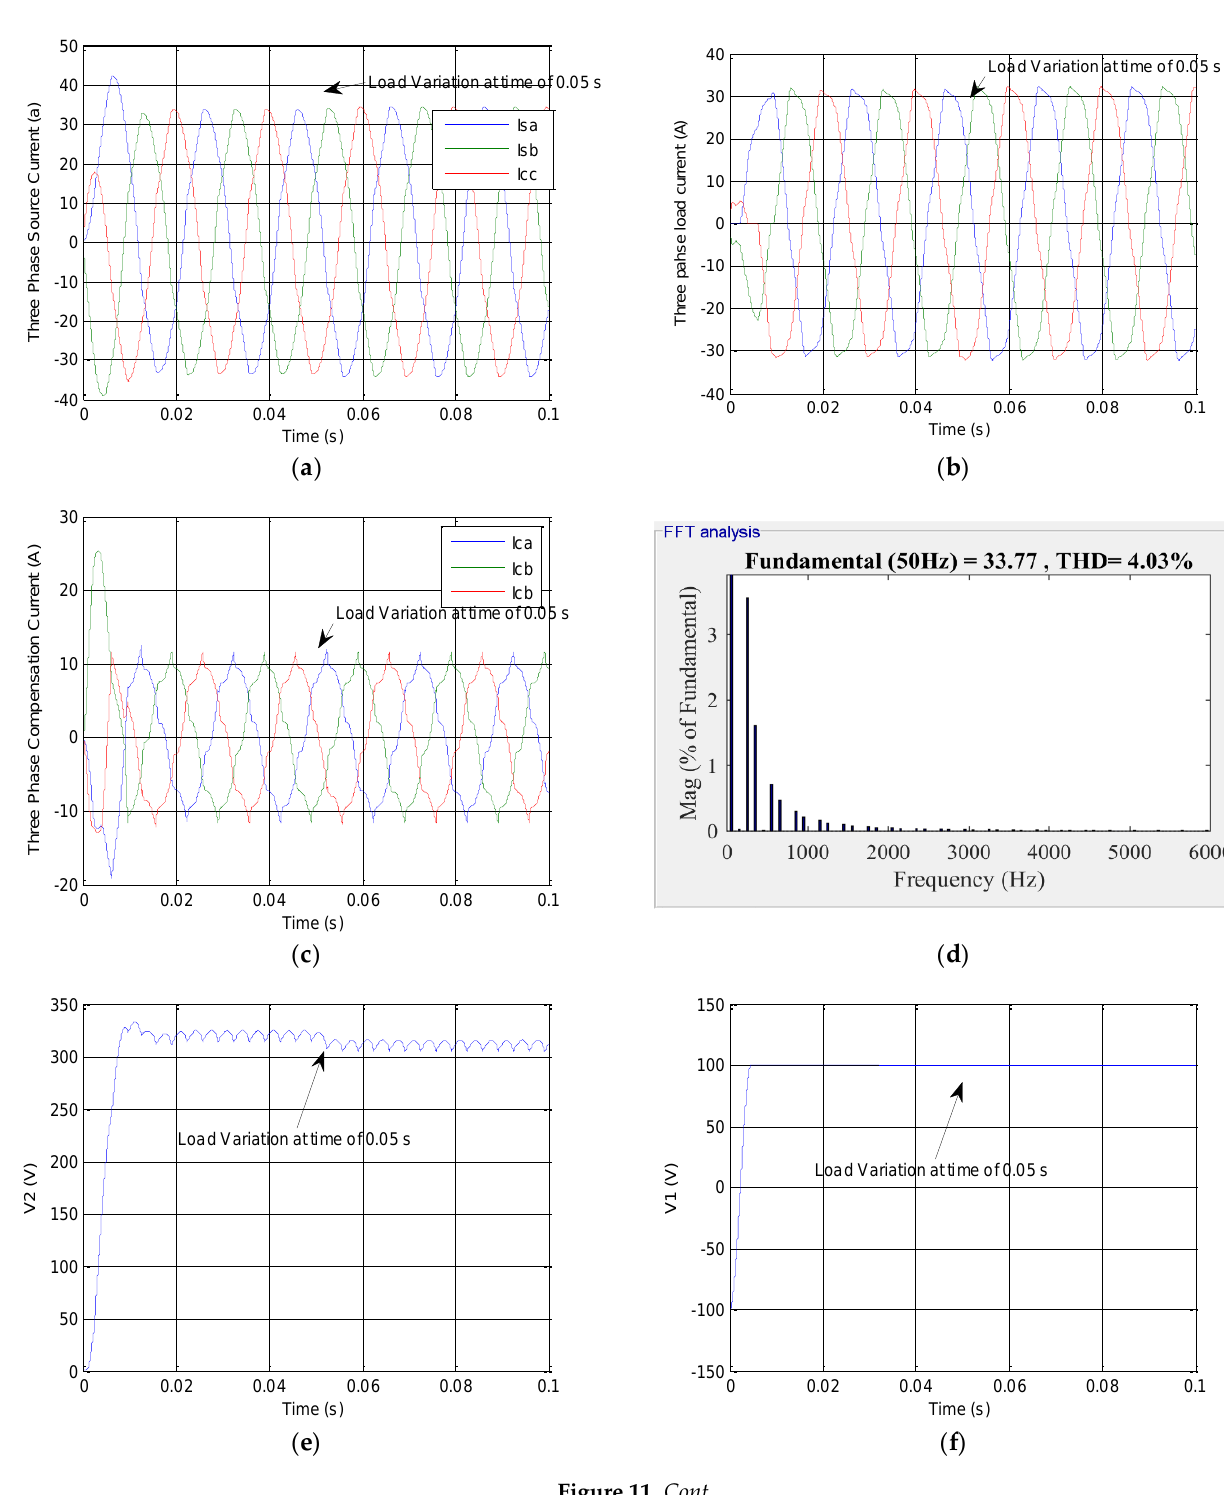
in Figure 11d. Figure 11g shows the output line voltage of the three-phase split source inverter. Figure 11h shows that supply voltage and source current were almost in phase. When the FLC controller was connected in the outer loop it performed well because the overall system was a nonlinear system. The DC link voltage remained constant. The source current harmonics were found to be 4.46% and 4.03% for various loads using the FLC over PI controller with a near to source current profile. Thus, the results proved the system dynamic performance during transient condition.